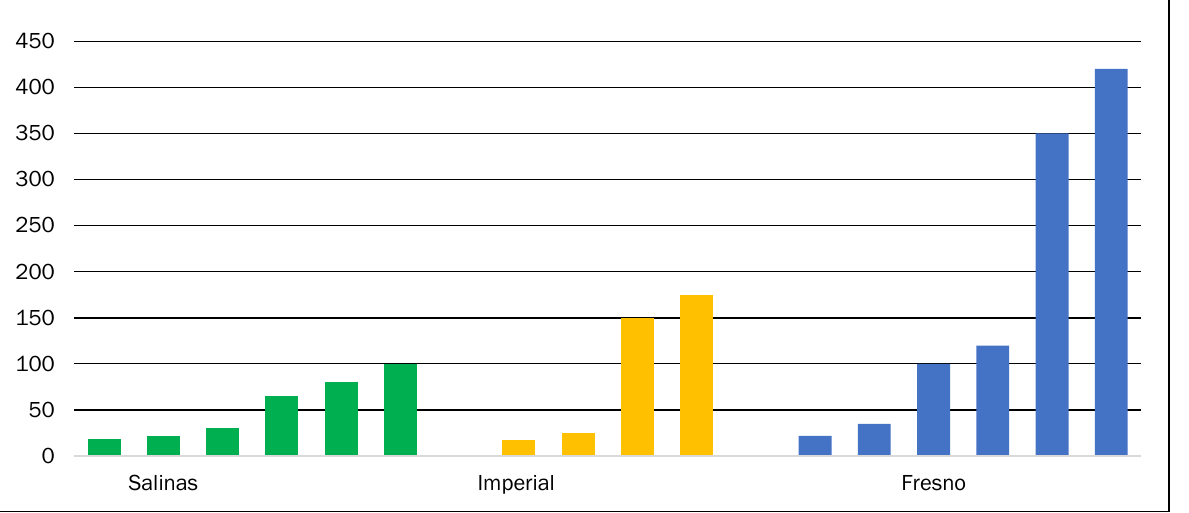
Figure 2. Crew Size by Region in This